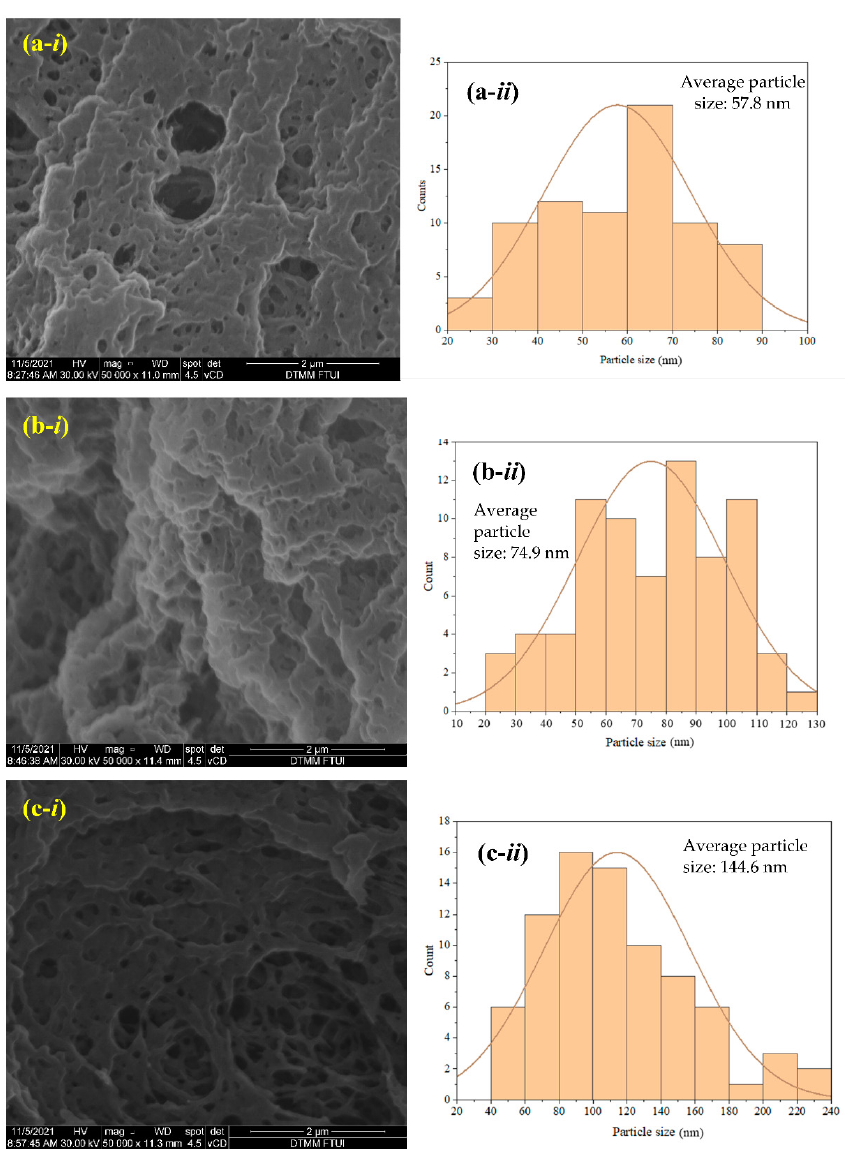
Figure 4. SEM images ( left ) with magnification (50,000 × ) and 30.0 kV for the CS-Tb 2 S 3 nanocompo- tion plots ( right ) were obtained from J-image ( n = 75 data samples) analysis of SEM results for